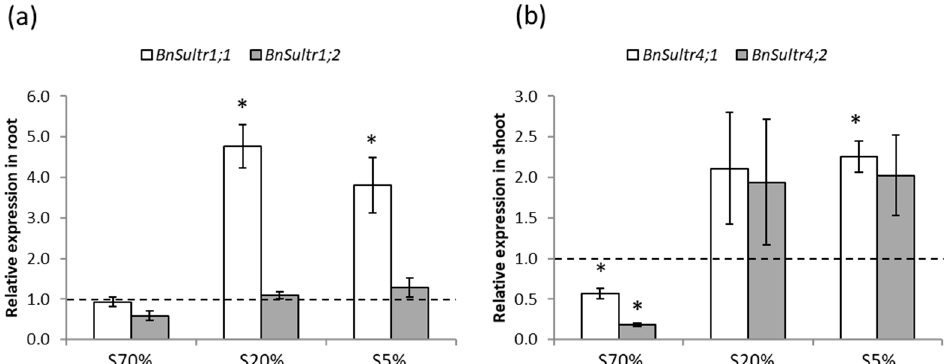
Figure 4. Relative expression of BnSultr1;1 and BnSultr1;2 in roots ( a ) and BnSultr4;1 and BnSultr4;2 in shoots ( b ) of S70%, S20% and S5% oilseed rape green seedlings 14 days after sowing on water (14 DAS). The expression level of BnSultr1;1 , BnSultr1;2 , BnSultr4;1 and BnSultr4;2 is relative to the result obtained in S400% green seedlings at 14 DAS, shown by the dotted line. Seedlings were grown from seeds harvested on plants subjected to plethoric S nutrition (400% of plant S needs provided, S400% seeds) or subjected to a S limitation from the beginning of plant growth with 70%, 20% and 5% of plant S needs provided (S70%, S20% and S5% seeds, respectively). Values correspond to means ± SE (n = 3) ( p <0.05). * Significant difference from the value of S400% green seedlings ( p <0.05).